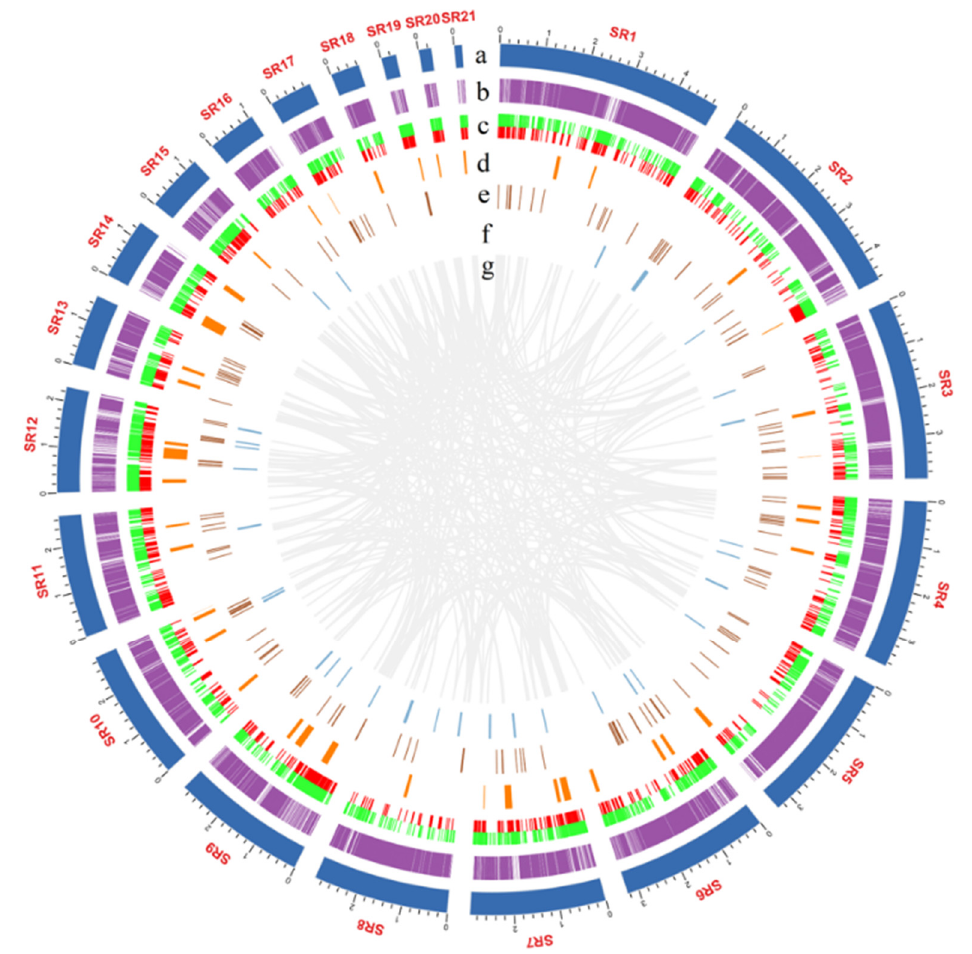
Figure 2. Circos graph of the characteristics of the Stropharia rugosoannulata genome. ( a ) 21 scaffolds. ( b ) Gene density. ( c ) Transposable elements (TEs), of which transposons are marked in red and retrotransposons in green. ( d ) SNP density. ( e ) Non-coding RNA. ( f ) Gene clusters of secondary metabolites. ( g ) Large fragment duplication.